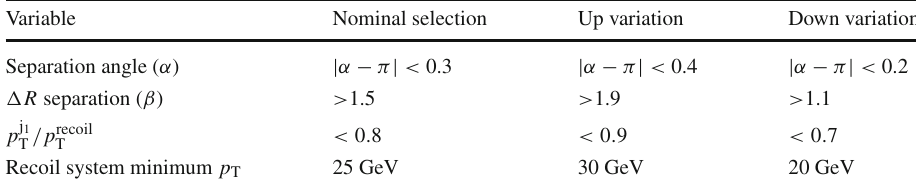
Table 4 Summary of the event selection and systematic variations considered for the multijet direct balance